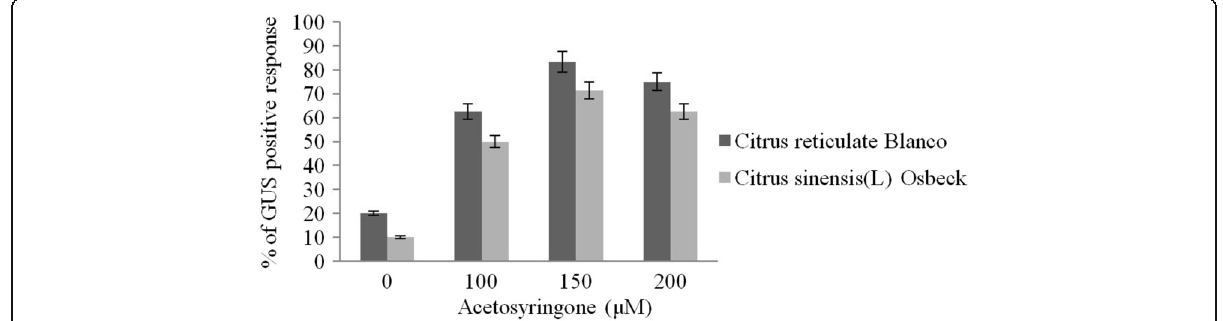
Fig. 5 GUS assay of the putatively transformed calli in different concentrations of acetosyringone